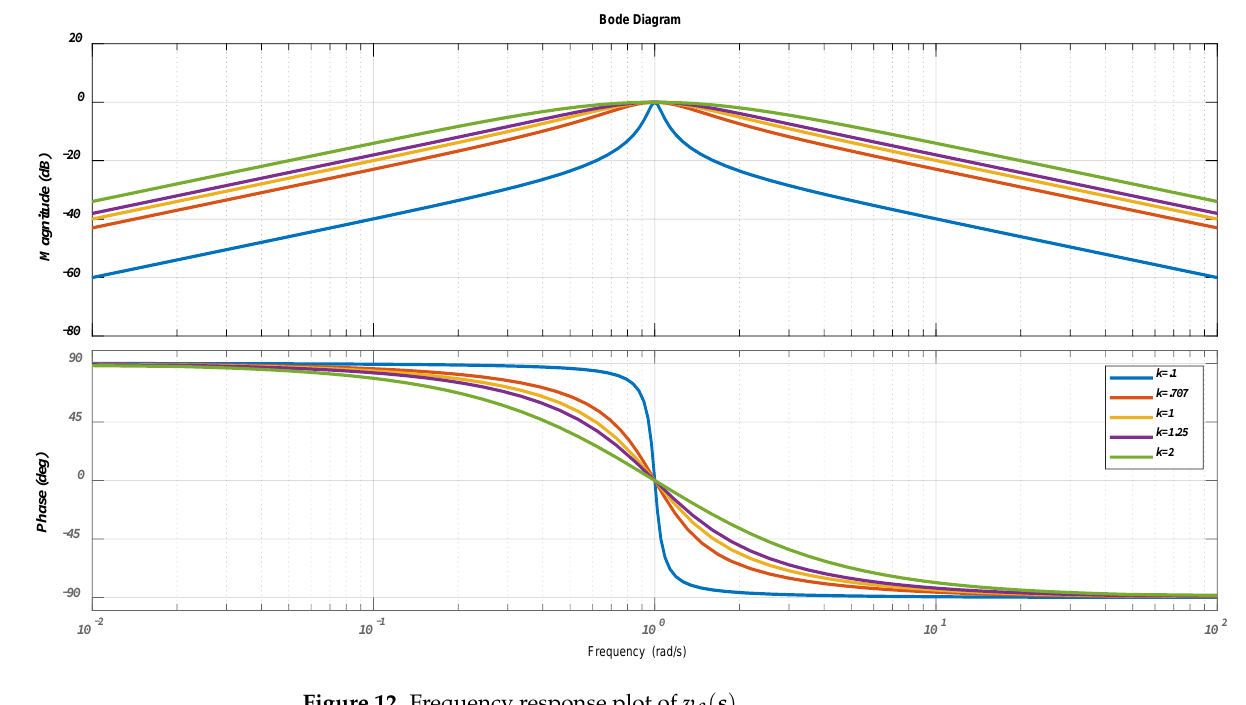
Figure 12. Frequency response plot of v β ( s